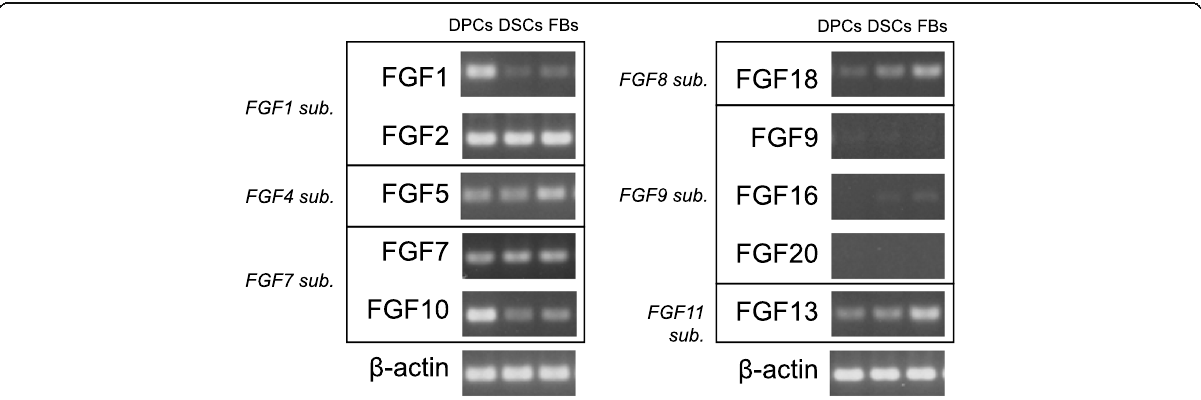
Fig. 1 FGF gene expression profiles in human scalp-derived dermal cell subsets. FGF1 and FGF10 were intensely expressed in DPCs compared to DSCs and sFBs. FGF5 , FGF13 , and FGF18 showed high expression in sFBs. FGF9 as well as FGF16 and FGF20, belonging to the same FGF9 subfamilywere barely expressed in sFBs. Samples were obtained from a single